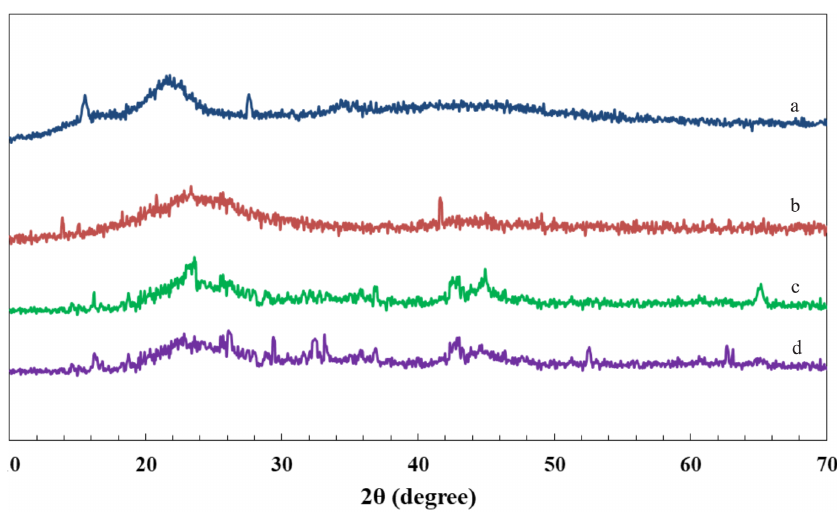
Figure 2. X-ray diffraction patterns of (a) RS, (b) RSAC, and (c) nZVFe–RSAC before reacting with Pb(II); and (d) nZVFe–RSAC(2) after reacting with Pb(II).